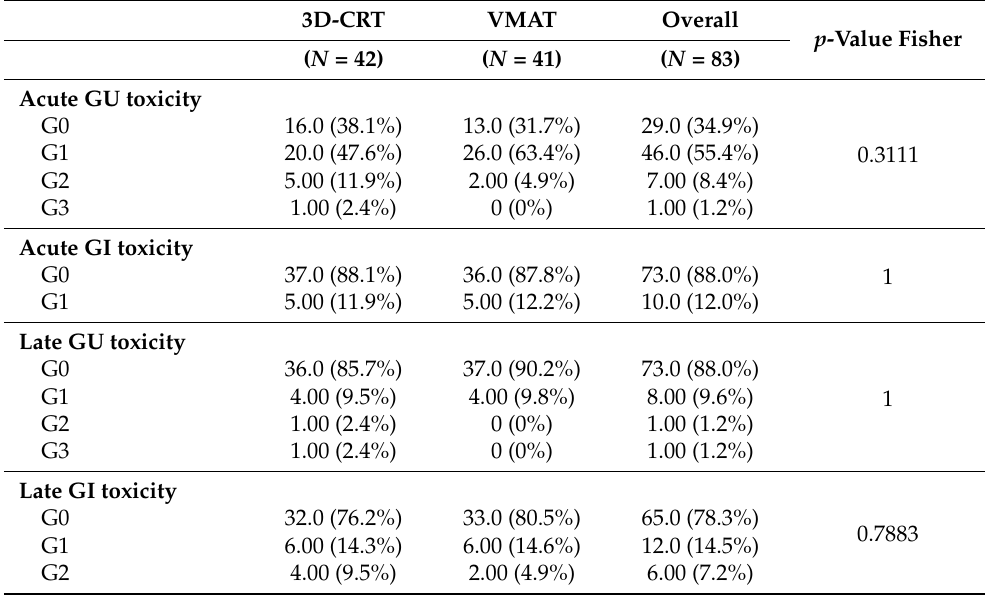
Table 3. Incidence of acute and late adverse